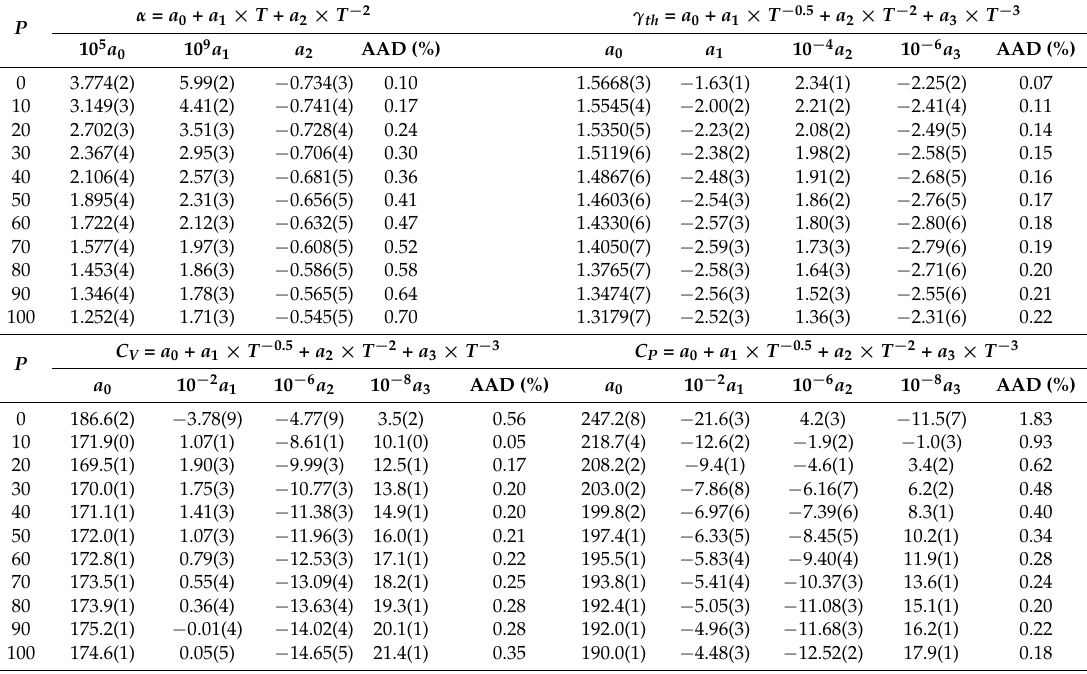
Table 7. Polynomial fitting results for α , γ th , C V and C P from 300 to 1500 K at different P (GPa), calculated using the GGA method.